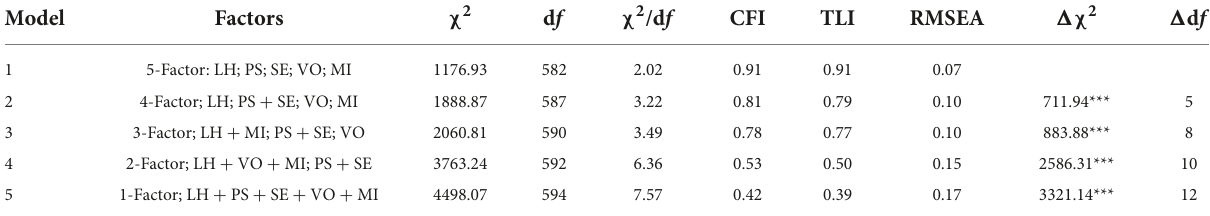
TABLE 2 Confirmatory factor analysis of